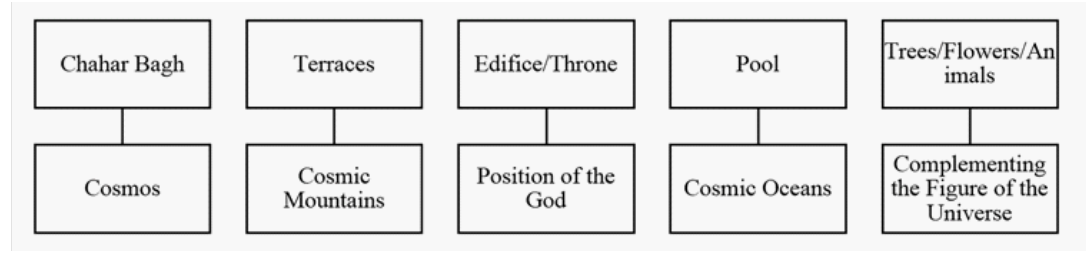
Figure 14. Symbolism in chahar-bagh, Source: author based on (Alemi